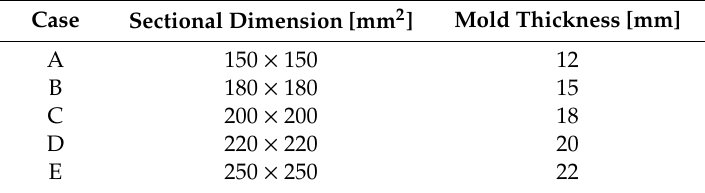
Table 3. Di ff erent schemes for evaluating the optimal Table 3. Different schemes for evaluating the optimal frequency. Table 3. Different schemes for evaluating the optimal frequency.